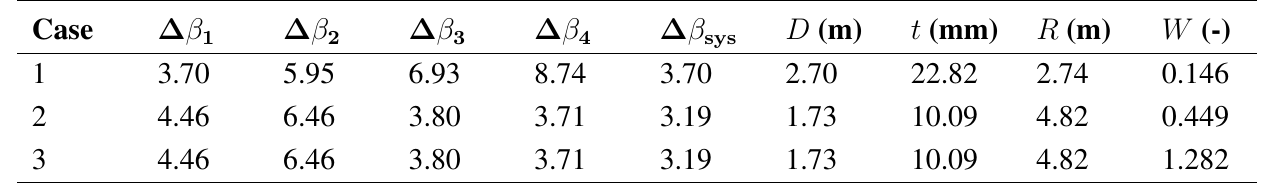
Table 8. Foundation and pile dimensions where the profitability W is maximized for three cases with different development levels, including the reliability indices of the four different considered failure modes together with the total annual reliability index of the considered system ( ∆ β ), including a minimal annual reliability index for the different failure modes sys ≥ 3 . 7 ) as a side equal to or larger than 3.7 ( ∆ β X